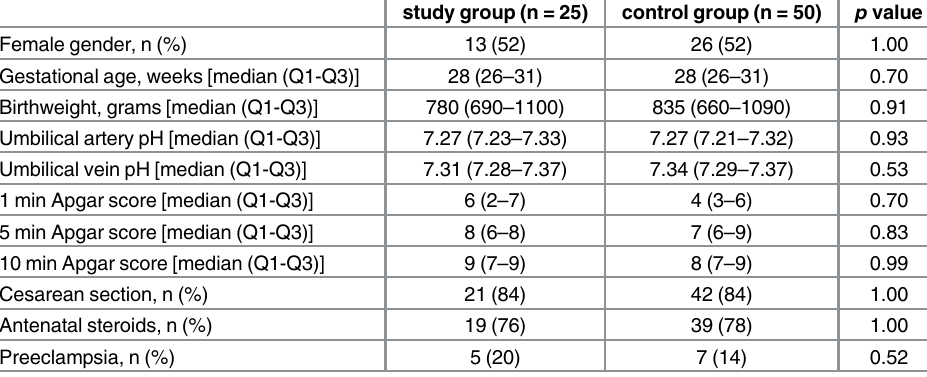
Table 1. Demographic and perinatal